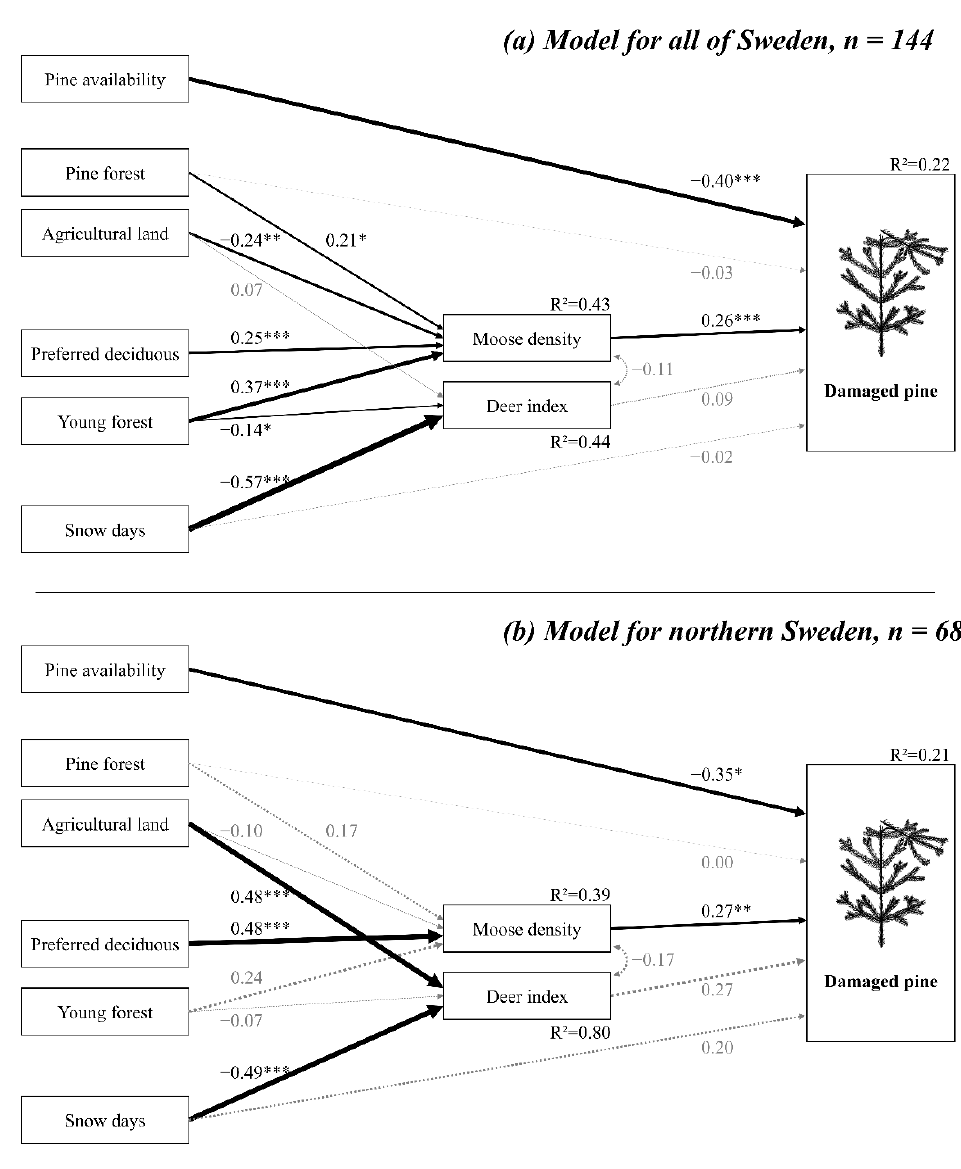
Figure 3. Path analysis results for ( a ) the national model for all of Sweden and ( b ) the model for northern Sweden showing direct and indirect effects of forest composition , land use , forage availability , climate , and cervid populations on browsing damage . Significant effects are illustrated with solid black arrows and non-significant results with punctuated light grey arrows. The thickness of the paths has been scaled based on the standardized path coefficients, which are also displayed with their respective significance levels of * p < 0.05, ** p < 0.01 and *** p < 0.001. The model for southern Sweden is not displayed, as it resulted in a poor fit between our hypothesized model and the data.